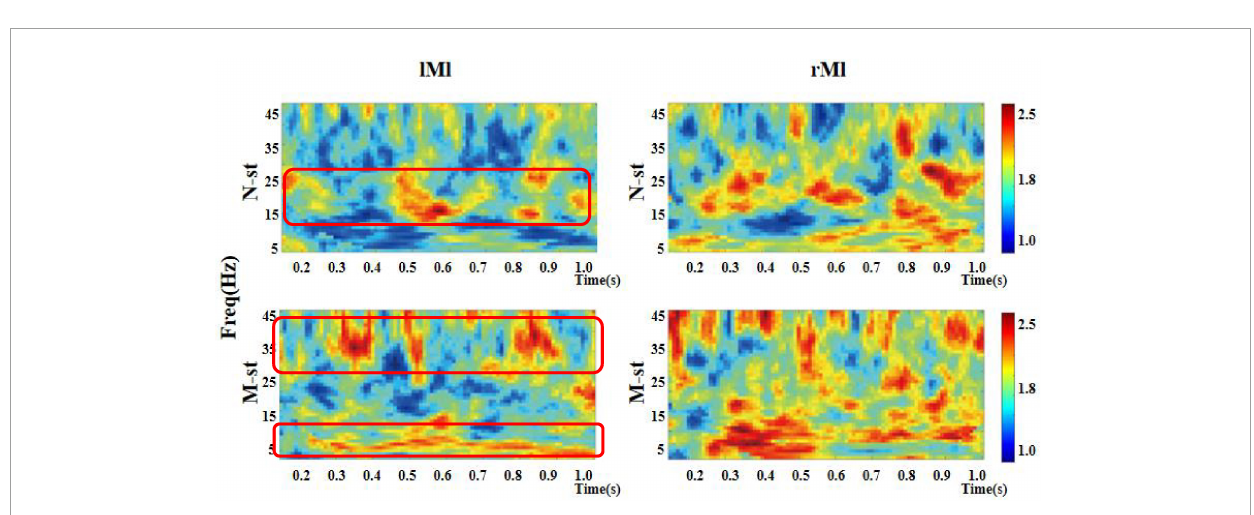
FIGURE7 Time-frequency distribution of ITPC in left motor cortex and right motor cortex. "lMl" represents the left motor cortex and "rMl" represents the right motor cortex. "M-ST" represents the true meaning sound stimulation group, and the "N-ST" band represents nouns stimulation group. The distribution of ITPC values in left motor cortex was significantly different. There was no significant difference in the distribution of ITPC in right motor